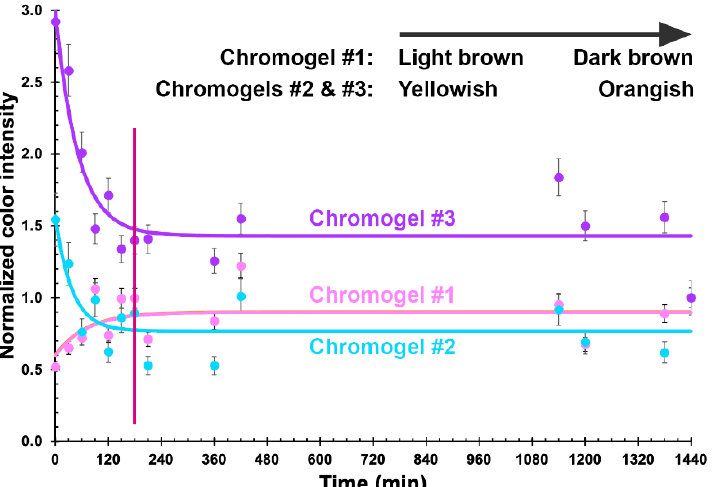
Figure 8. Normalized integrated color density of the three chromogels containing phage particles, sodium 1,2-naftoquinone-4-sulfonate, gelatin, and casein, further contacted with a fixed amount of P. aeruginosa cells, throughout the bioreaction time, allowing us to select an optimized bio-reactive chromogel. Values represent the mean of three independent assays. Error bars represent the standard deviation.